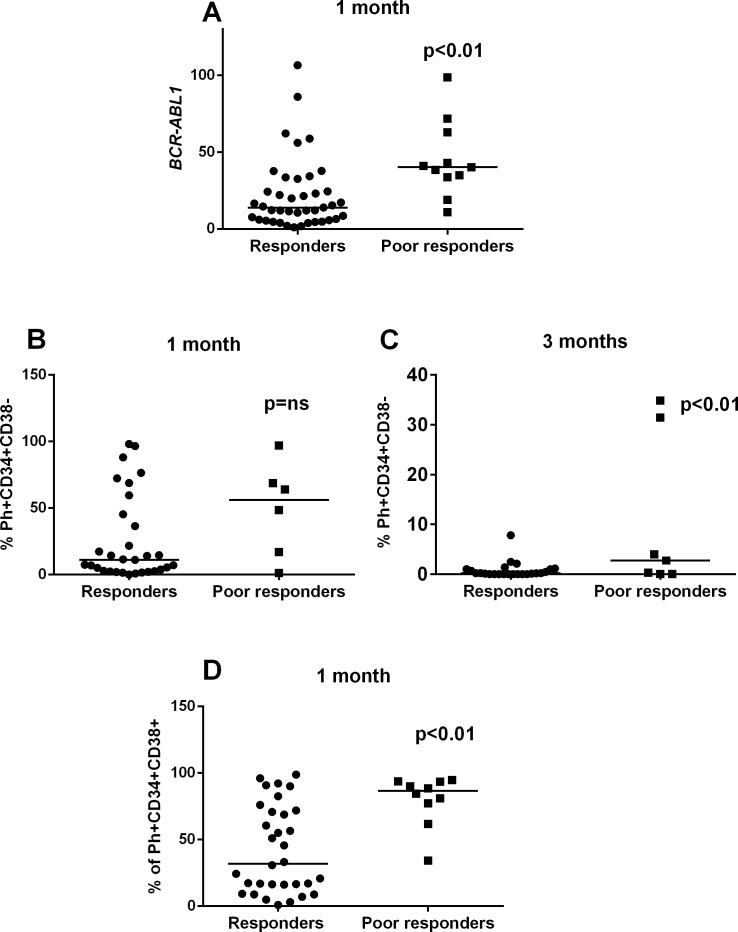
The Ph+CD34+CD38- cells are eradicated more slowly in poor responders.A) At 1 month, the BCR-ABL1 transcript level was significantly higher in poor responders (median 40.2%, range 11–98.7) compared to responders (median 13.9%, range 0.9–106.6) (p<0.01) B) At 1 month, the proportion of Ph+CD34+CD38- cells in poor responders (median 56.2%, range 1.1–97) and responders (11.1%, range 0–98.0) C) At 3 months, poor responders had a significantly higher proportion of Ph+CD34+CD38- cells (median 2.8%, range 0–34.9) versus responders (0.2%, range 0–7.8) (p<0.01). D)
Poor responders have a significantly higher percentage of Ph+CD34+CD38+ cells at 1 month (median 86.5%, range 34.2–94.8) compared to responders (median 32.0%, range 0.9–98.8) (p<0.01). Statistical significance was analyzed with an unpaired two-tailed t-test, and median values are noted with lines.